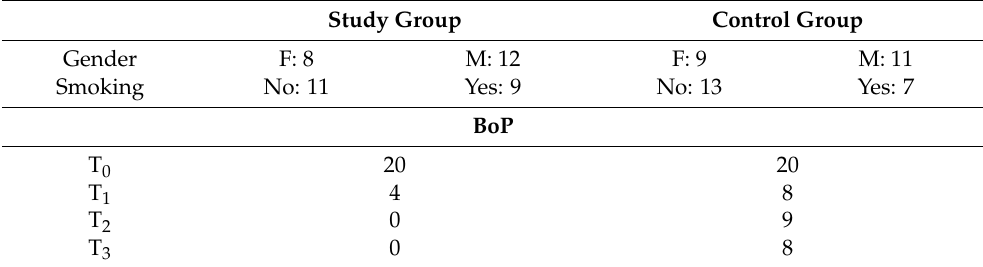
Table 2. Categorical characteristics of Study Group and Control Group.